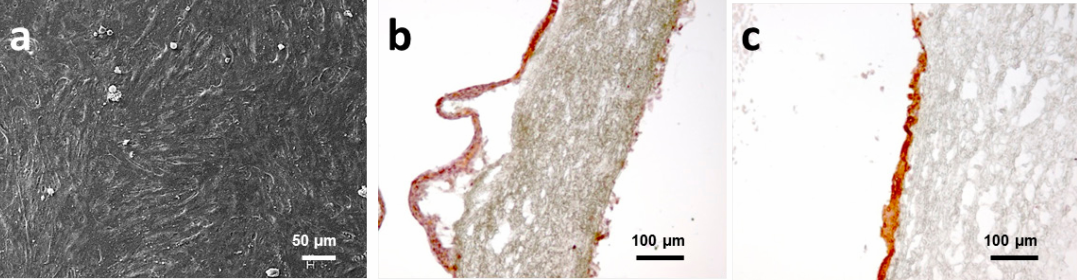
Figure 14. SEM ( a ) and IHC analysis ( b = TE-7, c = CD31) of seeded PU after flow exposure (10 to 40 dyn/cm 2 ) in the all-in-one bioreactor system show a confluent and flattened lining with ECs ( a , c ) and FBs ( b ).These are representative images of an experiment in